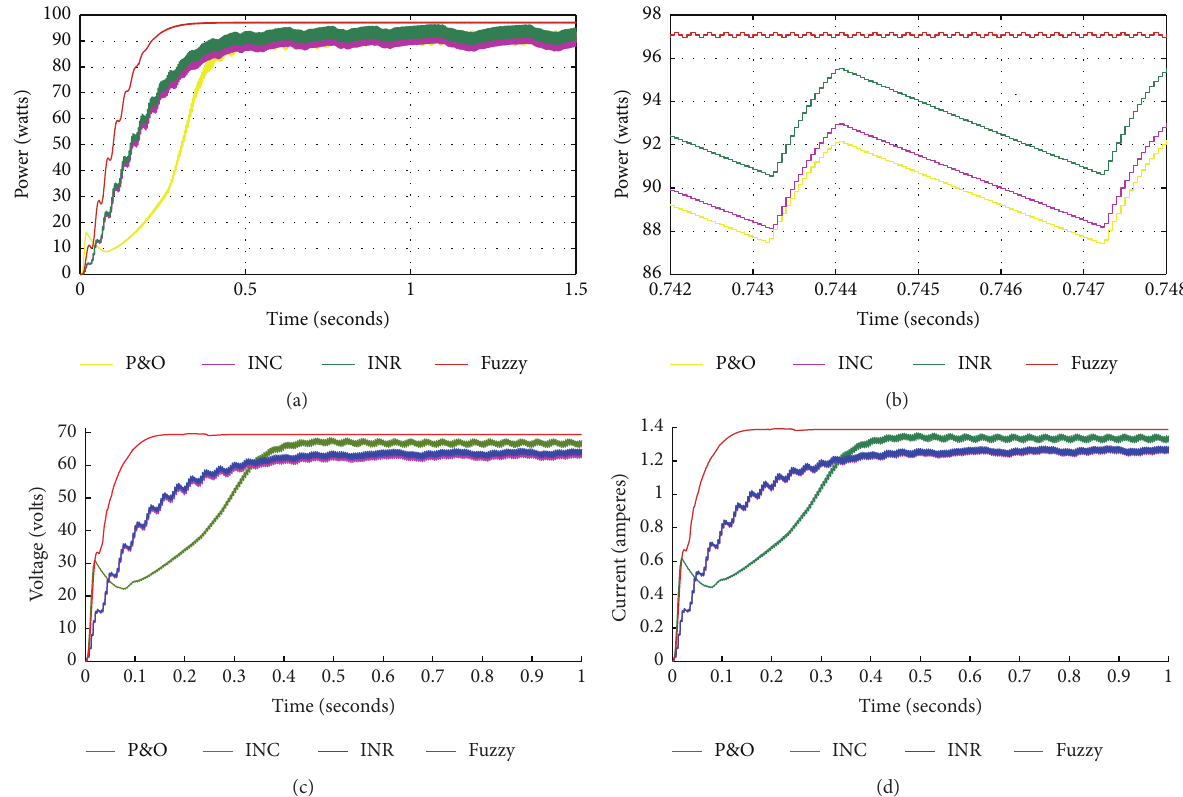
Figure 12: (a) Simulation result of fuzzy based system in comparison with perturb and observe (P&O), incremental conductance (INC), and incremental resistance (INR) method. (b) Zoomed view. (c) Voltage waveform. (d) Current waveform.